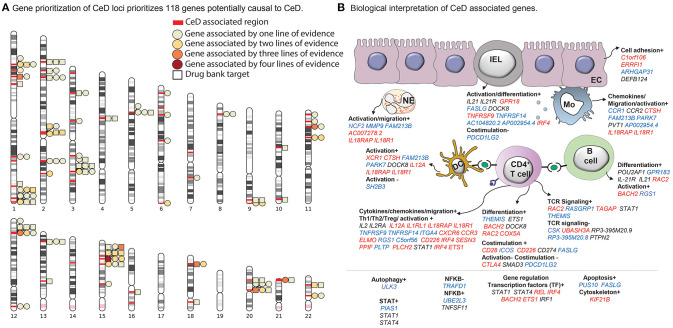
Celiac disease (CeD) prioritized genes and their proposed function and cell type. (A) A chromosome ideogram depicting the location of each prioritized gene identified in a CeD-associated genome-wide association study (GWAS) locus. Loci are marked with red bars. Genes depicted by a square are the target of an approved drug or a drug in development. All other genes are depicted by a circle. Each circle or square is colored according to the lines of evidence (see Methods) supporting its causal role. (B) Functions and cell types highlighted by the prioritized genes, according to our literature review (see Methods) (n = 118 genes; for 37 genes, neither a function nor a specific cell type on which the gene may operate could be specified). All genes contributing to a specific function are listed under the subheading and colored according to the change that leads to increased CeD risk: increased expression (red), decreased expression (blue), or undefined (black). The symbols + or – denote if a biological process is thought to be induced or repressed by the gene, respectively, according to literature.